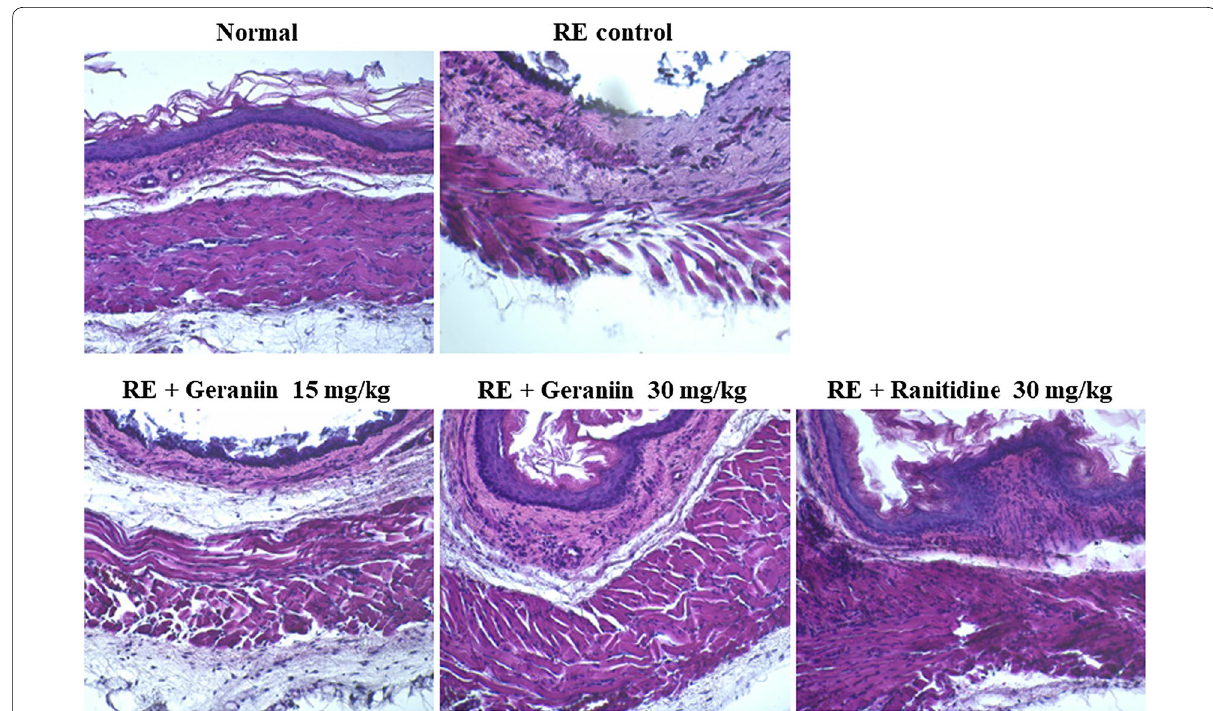
Fig. 4 The image of esophagus stained with Hematoxylin and eosin (H–E) in RE rats. Normal, untreated rats; RE Control, RE rats; RE 15 mg/kg body weight treated RE rats; RE